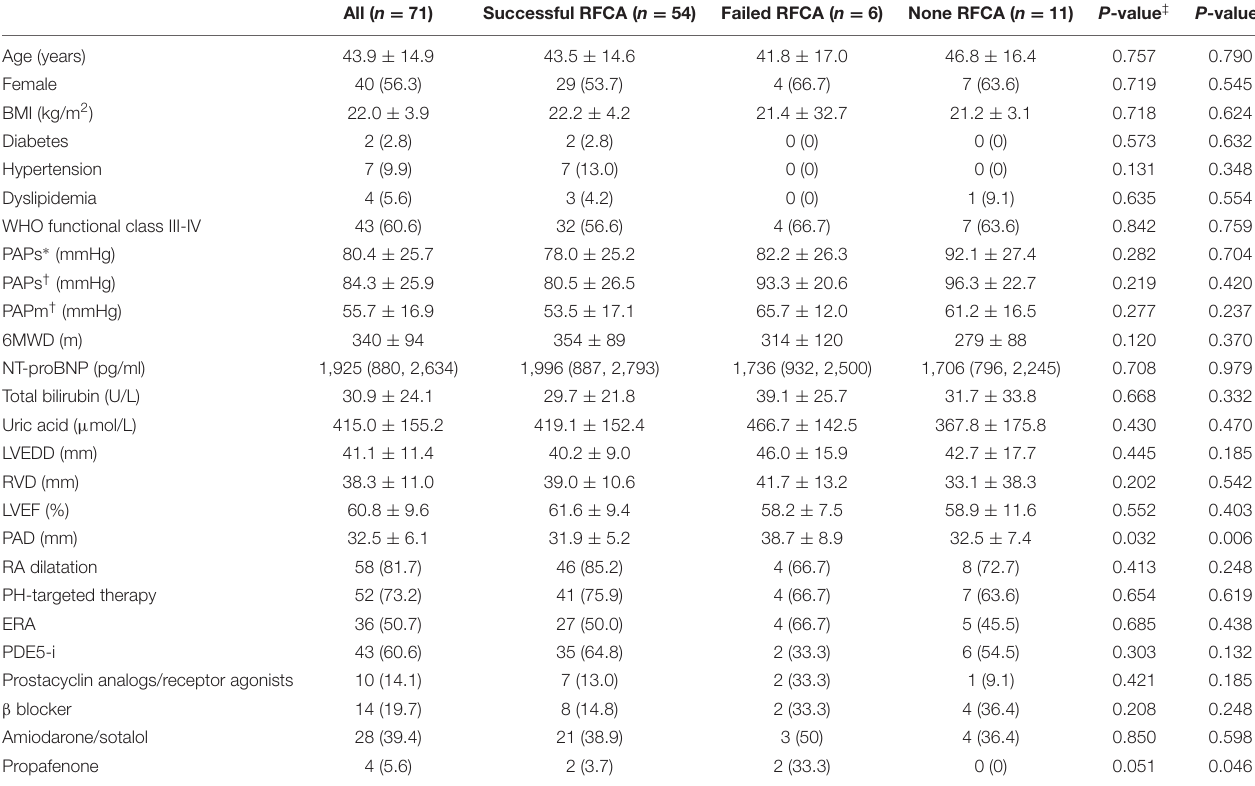
TABLE 1 | Baseline characteristics of the study population in relation to different outcomes of RFCA.